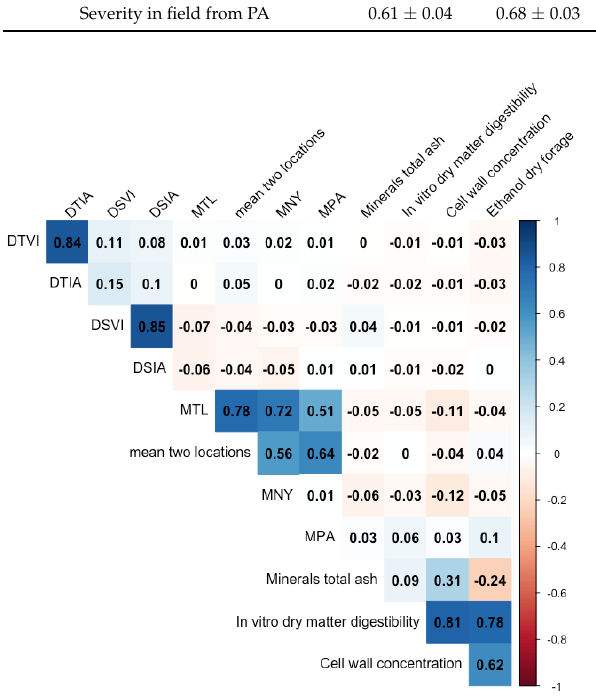
Figure 1. Correlation plot among BLUPs of severity from the detached leaf via vision (DTVI), via image analysis (DTIA), from leaf disk assay via vision (DSVI), via image analysis (DSIA), the highest score between two locations (MTL), mean from the two locations (TL), minerals total ash, in vitro dry matter digestibility, cell wall concentration, and ethanol conversion per day from a previous study [33].